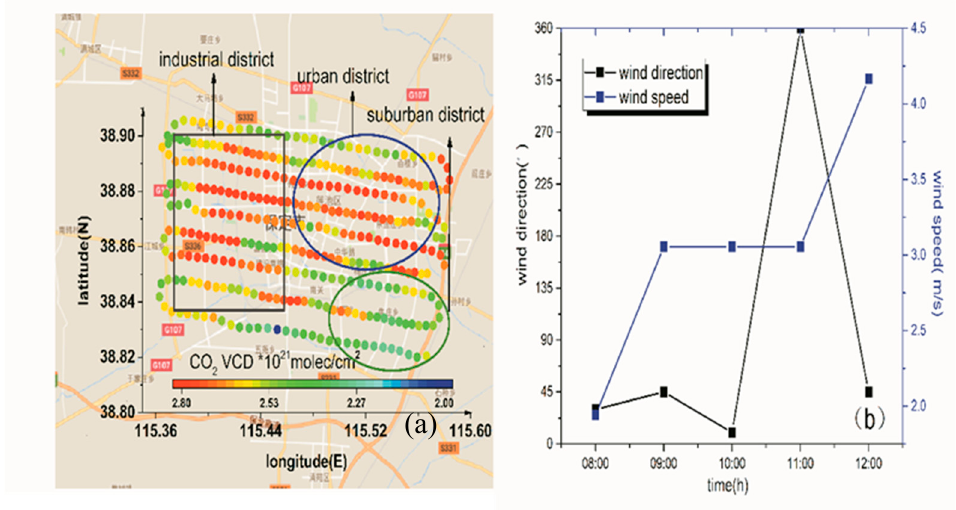
Figure 16. ( a ) Functional zoning of Baoding; ( b ) wind speed and wind direction of Baoding during the flight experiment .